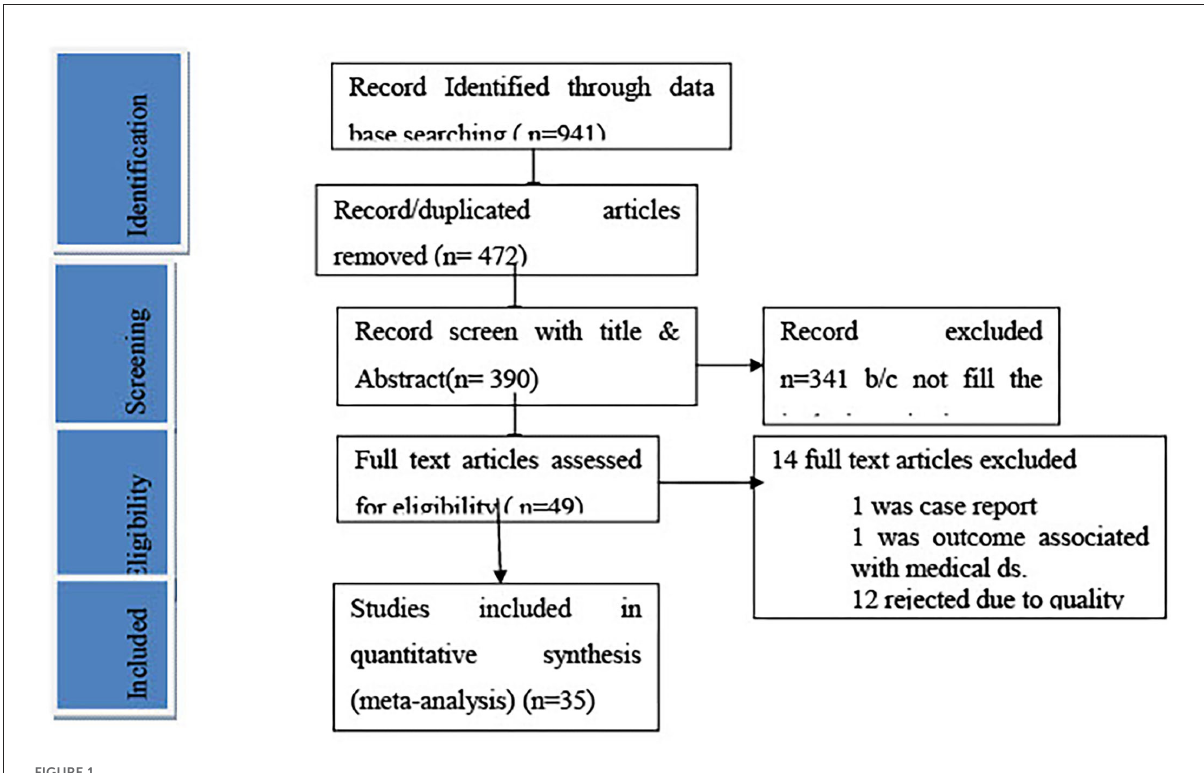
FIGURE1 PRISMA flow